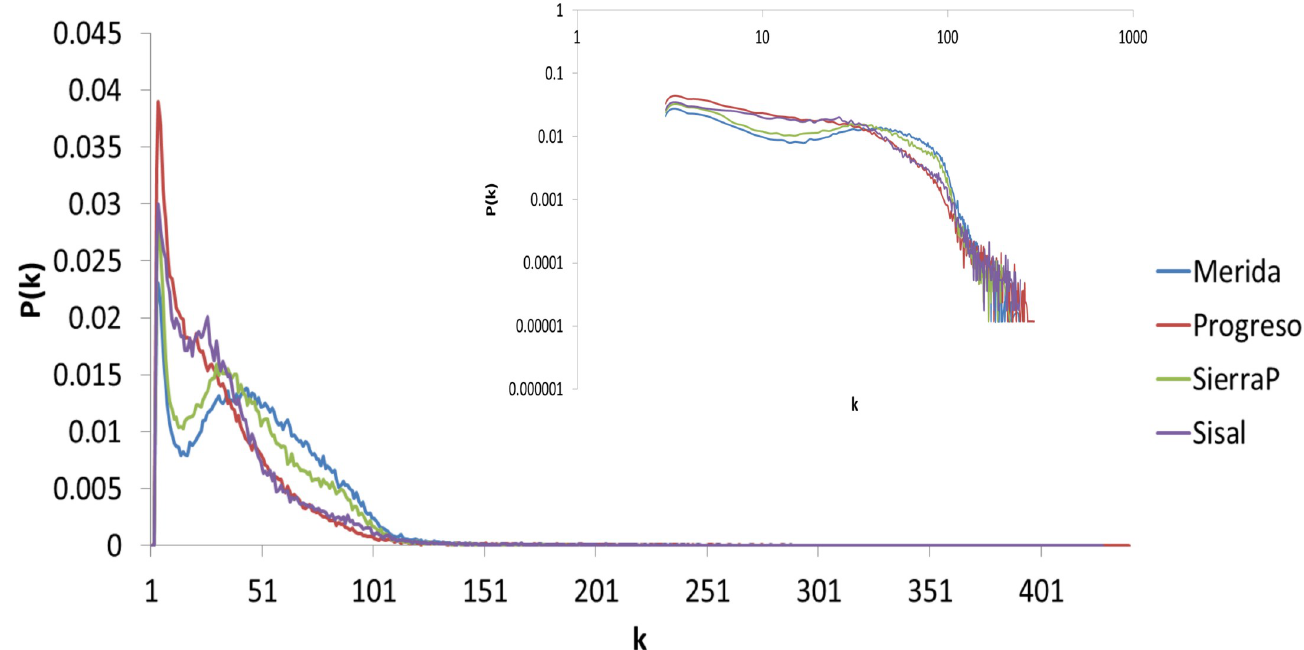
Fig 3. Degree distributions for networks generated with NVA. The figure shows the degree distributions in normal scales and in logarithmic scales in the inset. The non-coastal cites (Merida and Sierra Papacal) show a bell in the middle of the graph, while the coastal cities do not. These qualitative differences were quantified with the other connectivity measures mentioned above.